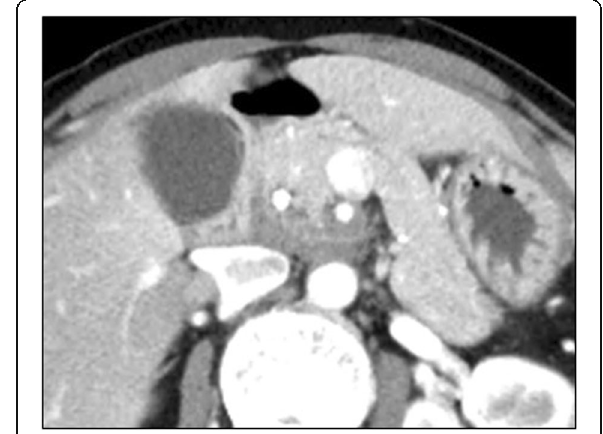
Fig. 2 MDCT showed remarkable tumor shrinkage after three courses of induction GEM + nab-PTX chemotherapy. However, the low-density area around the SMA still